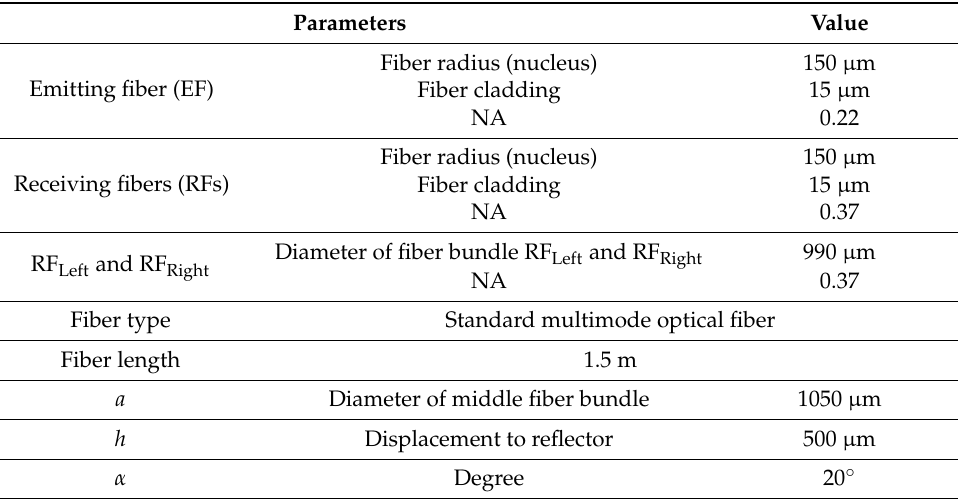
Table 1. Design parameters of the sensor fiber probe.